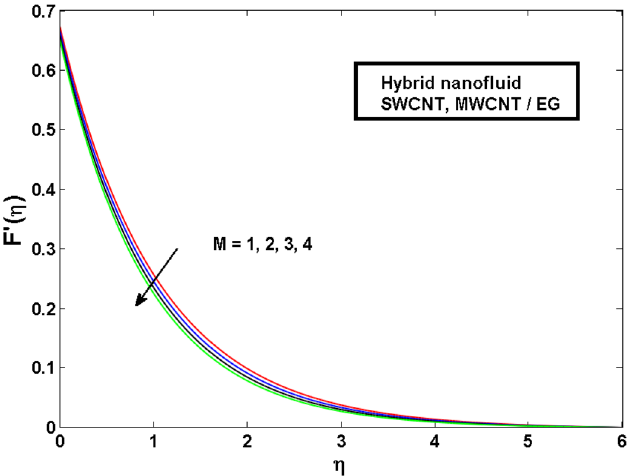
Figure 8. Illustration of a velocity profile F ′ (η) for different values of M .